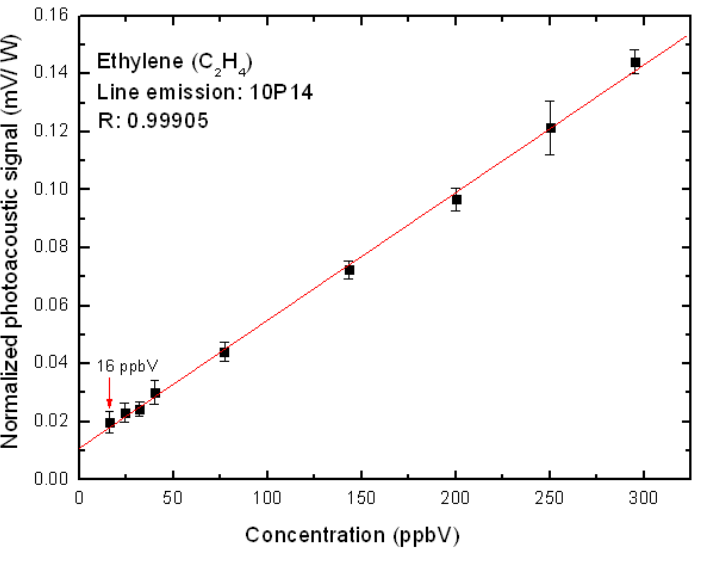
Figure 3. Calibration curve for ethylene (detection